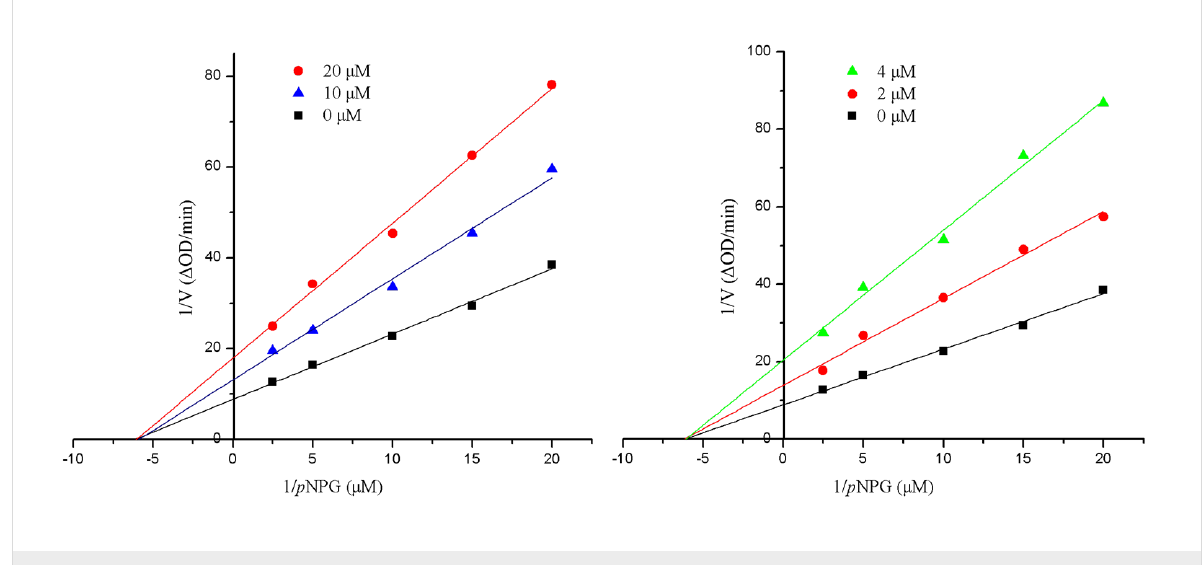
Figure 4: Kinetic analysis of the inhibition of α -glucosidase by 2 (left) and 6 (right).